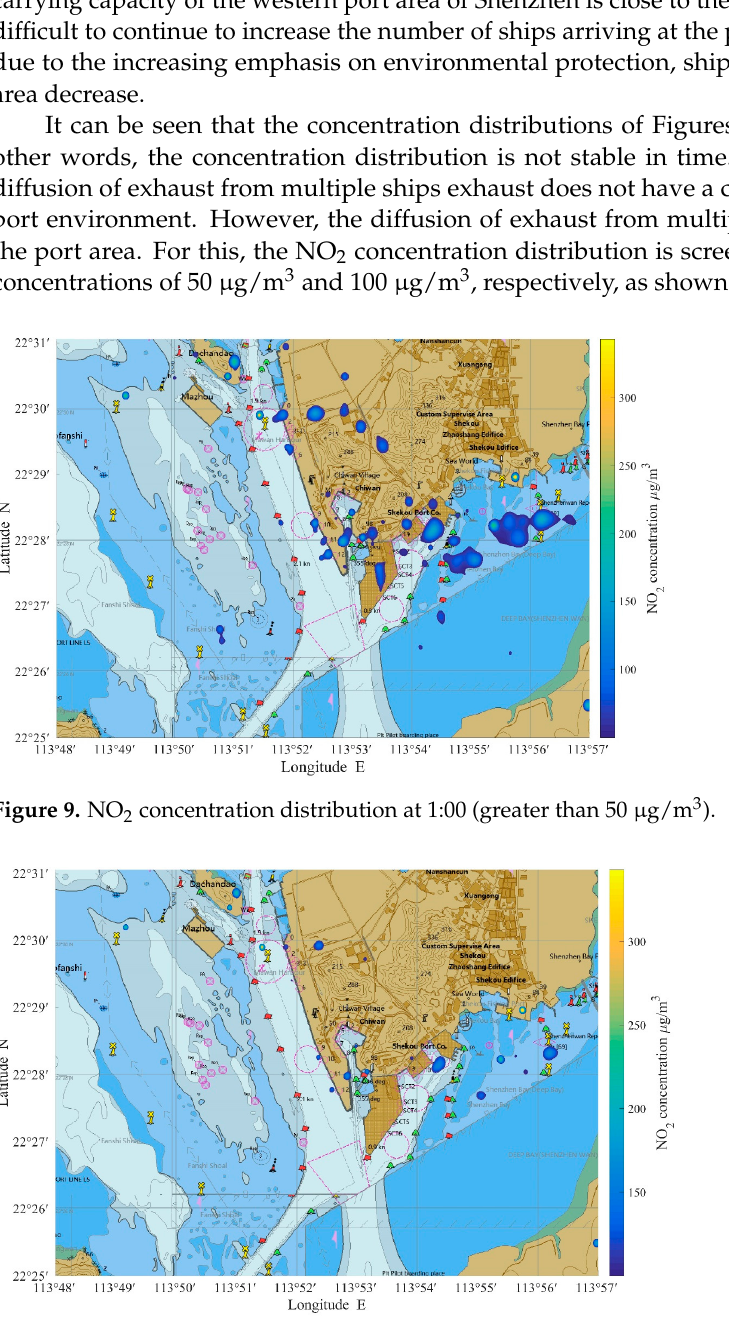
Figure 10. NO 2 concentration distribution at 1:00 (greater than 100 μ g/m 3 ).